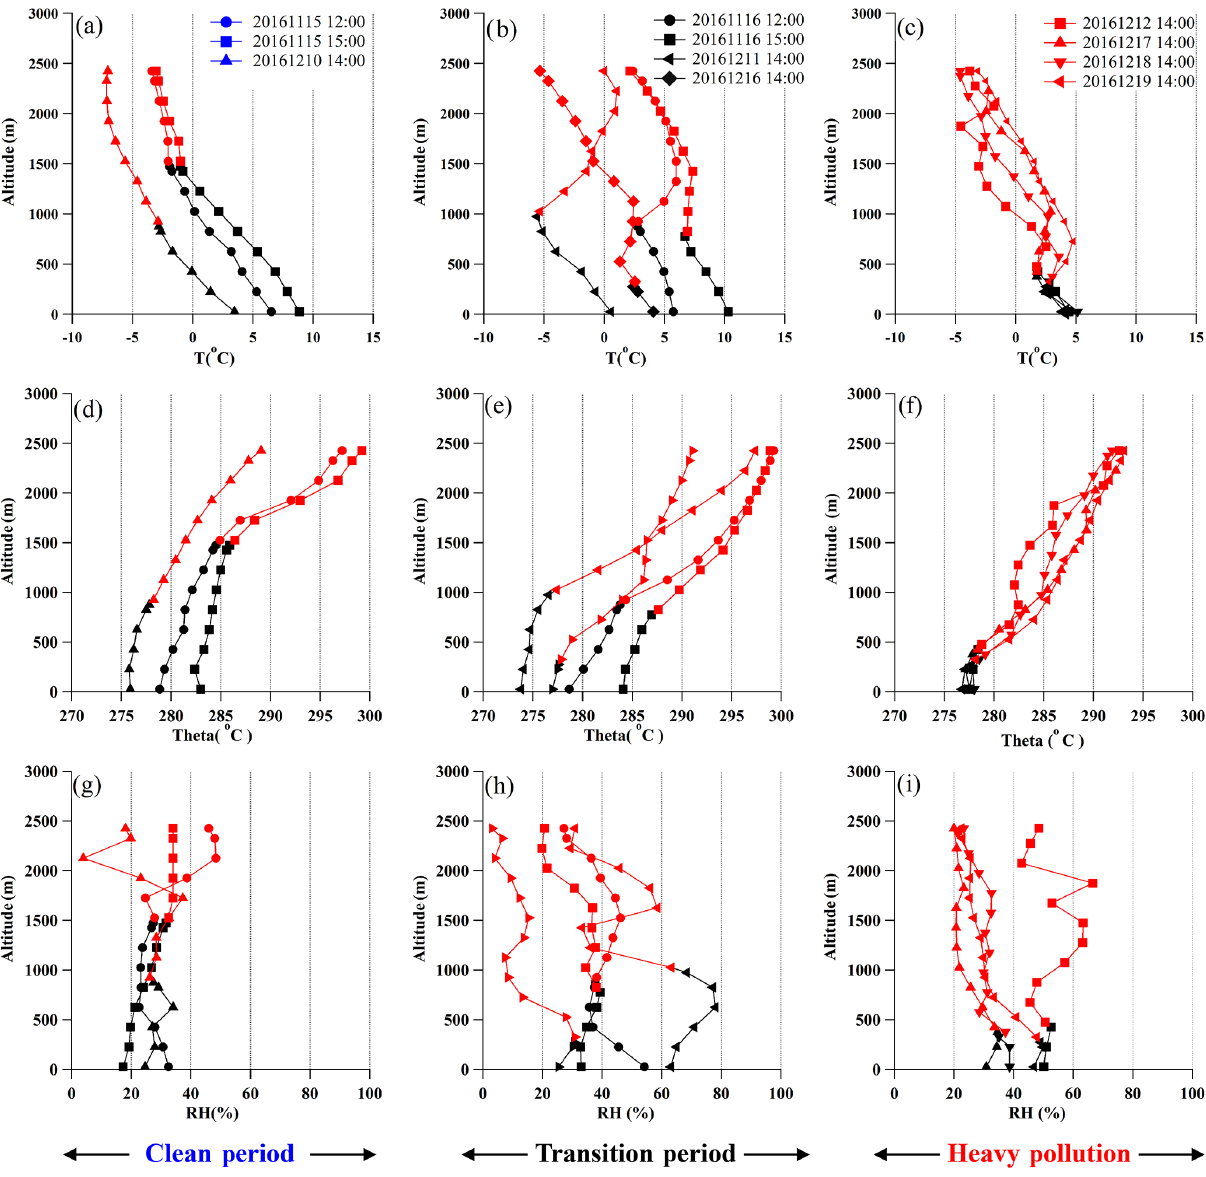
Figure 2. Vertical profiles of temperature (a, b, c) , relative humidity (d, e, f) and potential temperature (g, h, i) for clean period, transition period and heavy pollution period, respectively. The black and red dots represent inside the PBL and above the